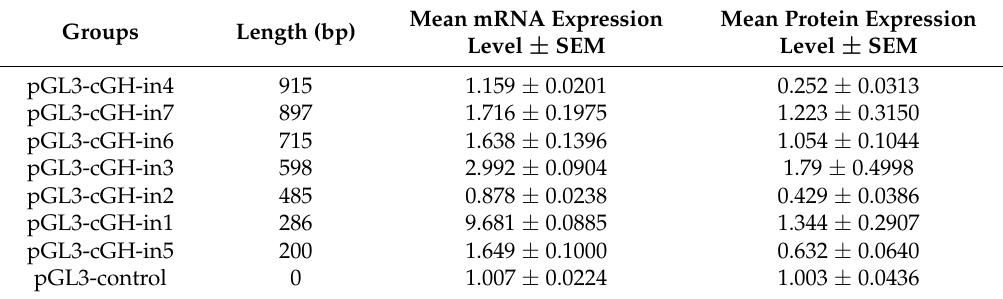
Table 2. The effect of 1st intron fragments with different length on reporter gene expression level. Mean mRNA Expression Mean Protein Groups Length (bp) Level ± SEM